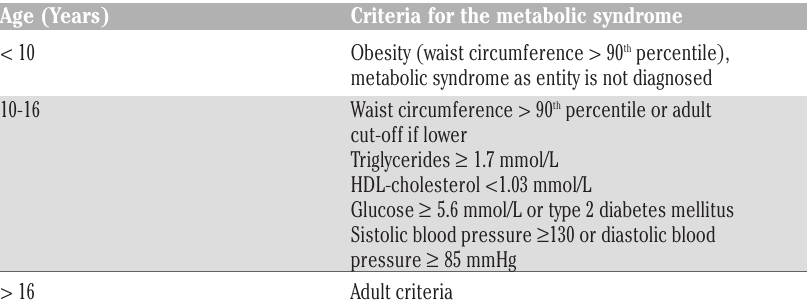
Table 2. Definition of pediatric metabolic syndrome according to the International Diabetes Federation.